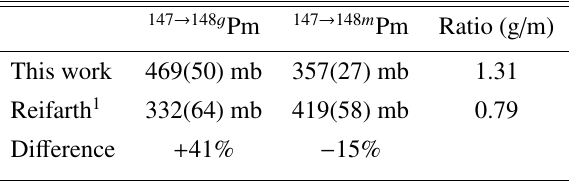
Table 1. Summary of the experimental values for the partial and total MACS at 30 keV for the 147 Pm( n ,γ )) reaction.